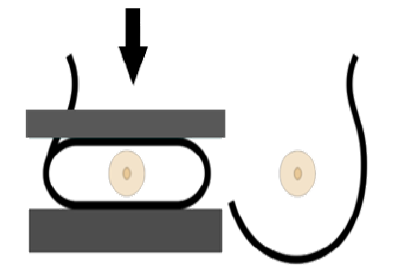
Figure 6. Cranio-caudal imaging technique